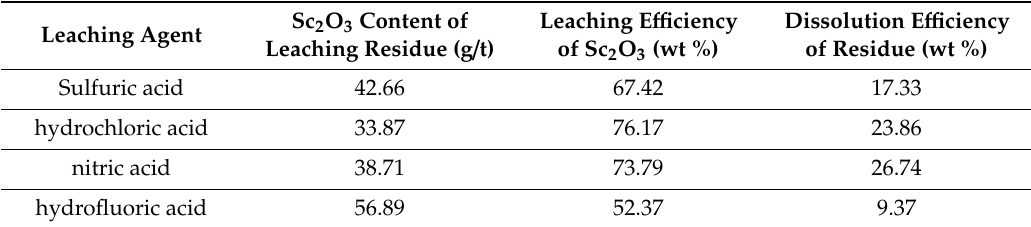
Table 5. E ff ect results of di ff erent leaching agent on scandium extraction.